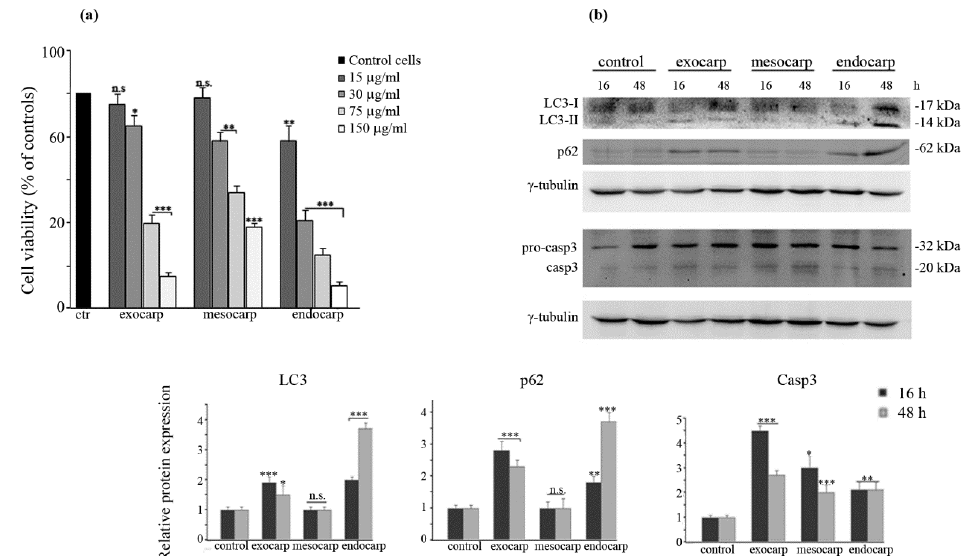
Figure 8. Effects of litchi fruit extracts on cell viability and autophagic and apoptotic markers in HCT116 cells. ( a ) Cells (7 × 10 3 ) were exposed to different doses of litchi exocarp, mesocarp or endocarp extracts and the incubation was protracted for 48 h. Cell viability was then assessed by a colorimetric MTT assay as reported in the Materials and Methods. The results are representative of three independent experiments. (*) p < 0.05; (**) p < 0.01; (***) p < 0.001 compared with control. ( b ) Western blotting of LC3, p62 and caspase-3 after treatment of HCT116 cells with litchi extracts (75 µg/mL) for 16 h or 48 h. The correct protein loading was ascertained by immunoblotting for γ -tubulin. Representative blots of three independent experiments and densitometric analysis are shown. (*) p < 0.05; (**) p < 0.01; (***) p < 0.001 compared with control.